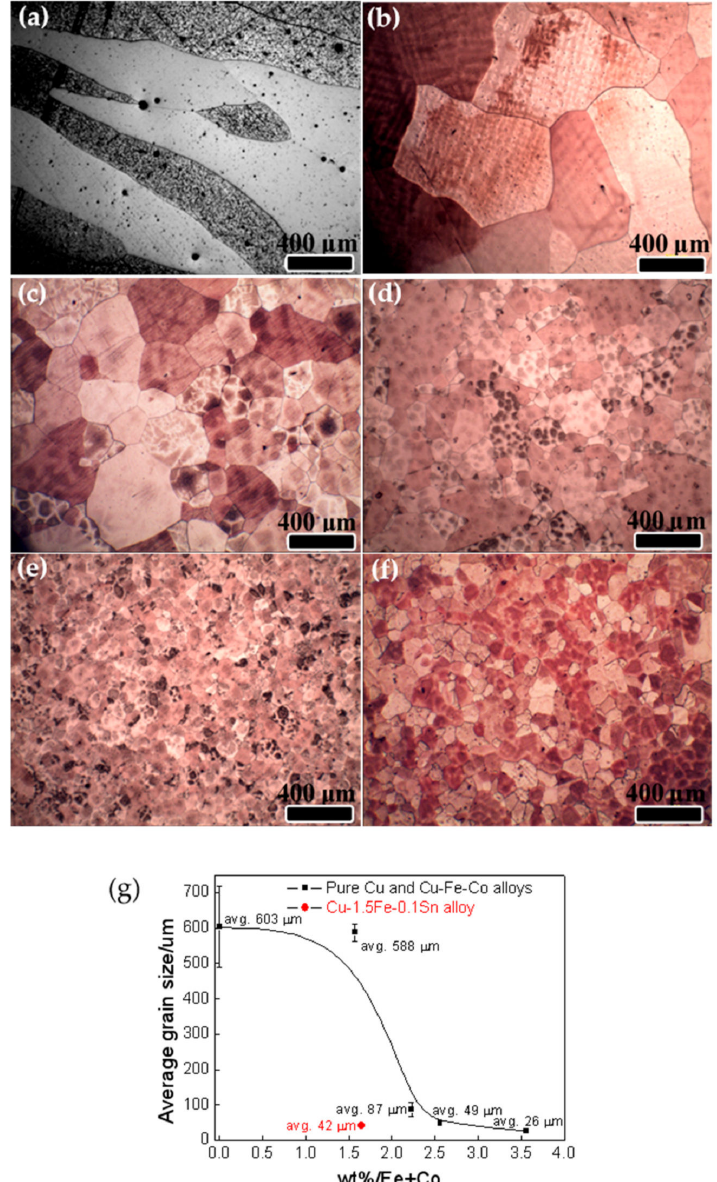
Figure 10. Optical micrographs (OM) of as-cast samples showing the effect of Fe+Co content and minor solute Sn on grain refinement. ( a ) Pure Cu; ( b ) Cu-1.0Fe-0.5Co alloy; ( c ) Cu-1.5Fe-0.5Co alloy; ( d ) Cu-2.0Fe-0.5Co alloy; ( e ) Cu-3.0Fe-0.5Co alloy; ( f ) Cu-1.5Fe-0.1Sn alloy; ( g ) Grain size (with standard deviation bars) as a function of actual Fe+Co content